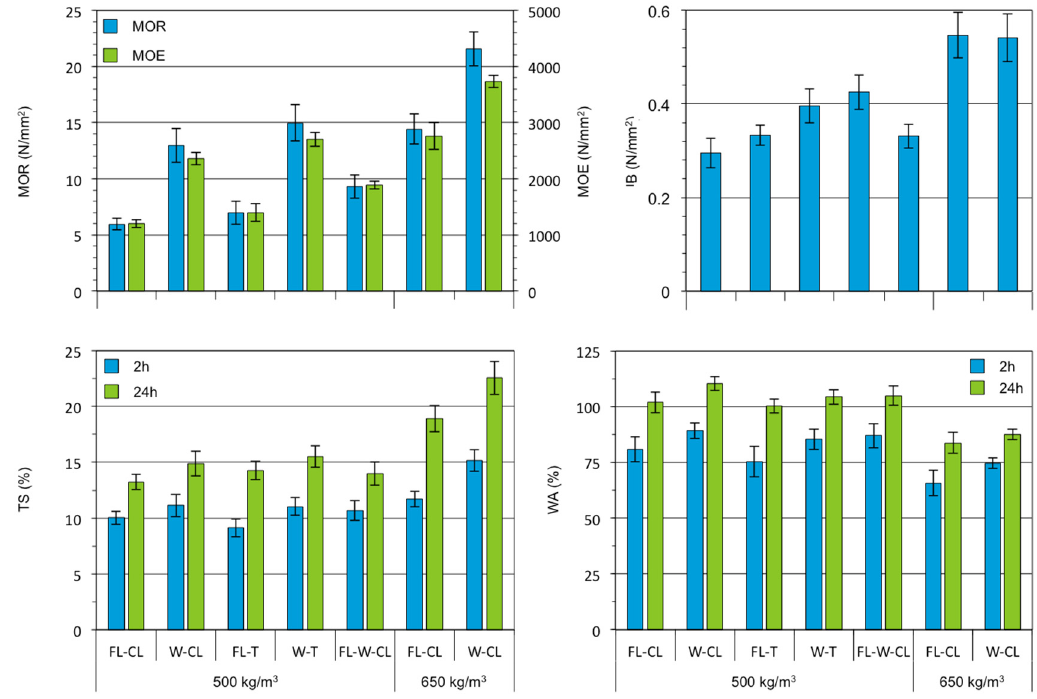
Figure 7. Properties of wood-reduced (target density 500 kg / m 3 ) and typical wood usage (650 kg / m 3 ) boards composed of different FL, CL, W, T, MOR, MOE, IB, TS, and water absorption (WA); error bars indicate standard deviation.